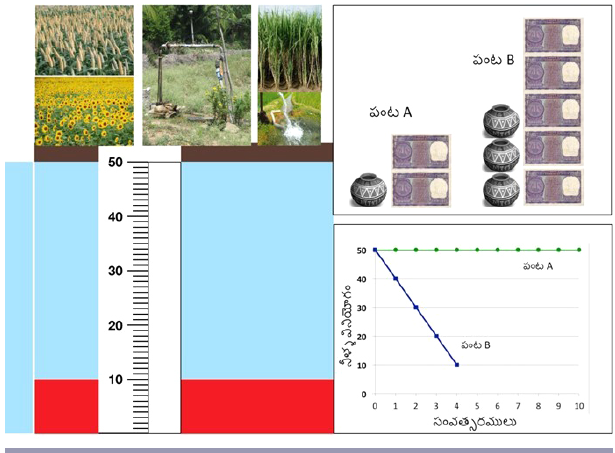
Fig. 1. Visual aid used in explaining the groundwater